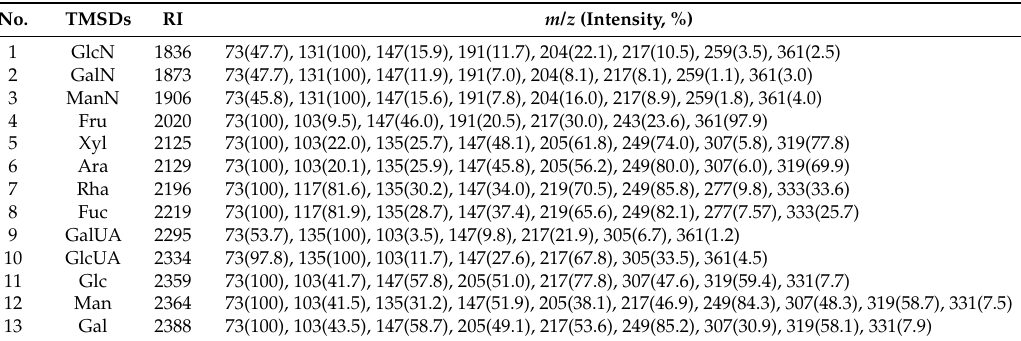
Table 1. Fragmentation patterns and RI values of all